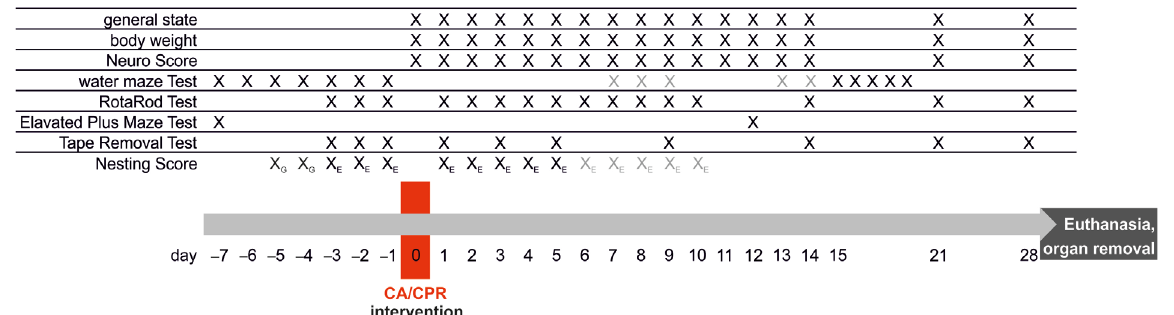
Figure 1. Experimental timeline for neurological and behavioral testing and CA-CPR. black: per- formed on this day, gray: performed about this day; X G : groups of mice, X/X E : single mouse.